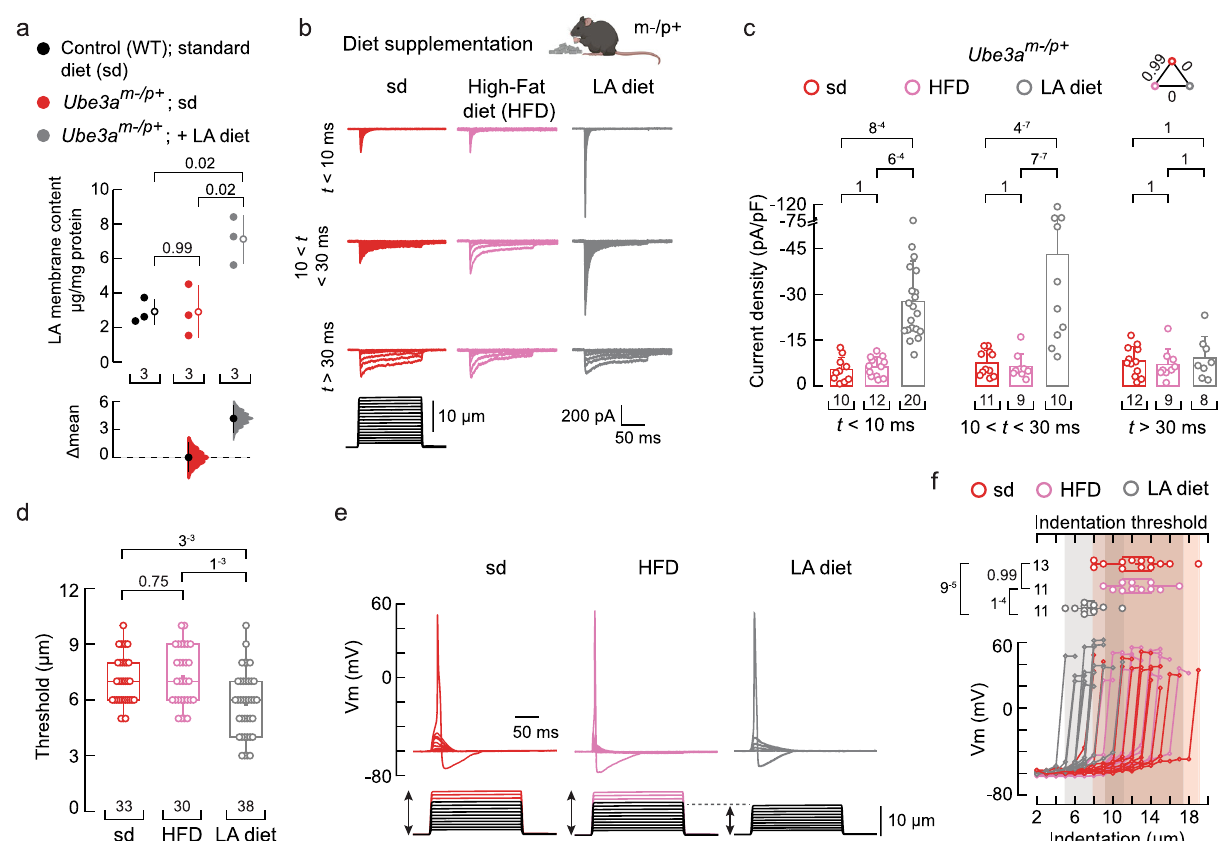
Fig. 7 | A LA-enriched diet increases Ube3a m – /p+ mouse mechano-currents and -excitability. a Cumming estimation plot showing the mean differences in the LA membrane content of DRG neurons from WT, Ube3a m – /p+ , and Ube3a m – /p+ mice fed with a LA-enriched diet, as determined by LC-MS. The raw data are plotted on the upper axes; each mean difference is plotted on the lower axes as a bootstrap sampling distribution. The mean differences are depicted as open circles; 95% con fi dence intervals are indicated by the ends of the vertical error bars. One-way ANOVA (F=11.09; p =0.0096) and Tukey multiple-comparisons test. b Representative whole-cell patch-clamp recordings elicited by mechanical sti- mulation ( − 60 mV) of rapidly, intermediate, and slowly-inactivating DRG neuron currents from Ube3a m – /p+ mice fed with a standard (sd), high-fat (HFD), or LA- enriched (LA diet) diet. Top, mouse cartoon was created with BioRender.com. c Current densities elicited by maximum displacement of DRG neurons from Ube3a m – /p+ mice fed with sd, HFD, or LA-enriched diets classi fi ed by their time constantofinactivation.Barsaremean±SD.Two-wayANOVA(F=25.36; p =1.69 − 9 )